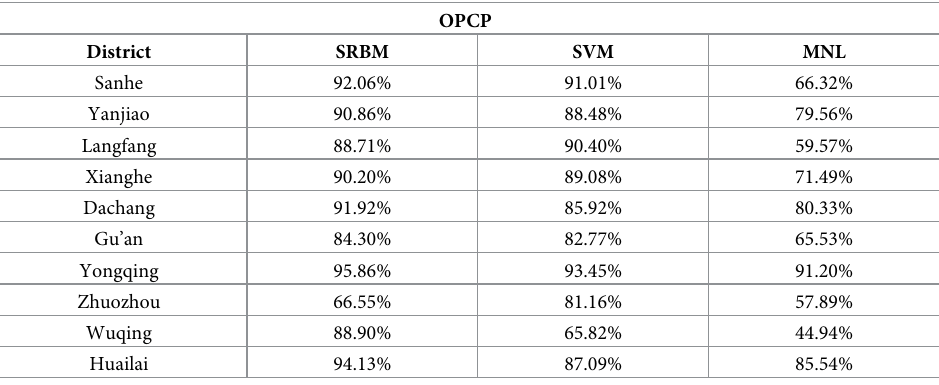
Table 8. The OPCP of SRBM, SVM and MNL